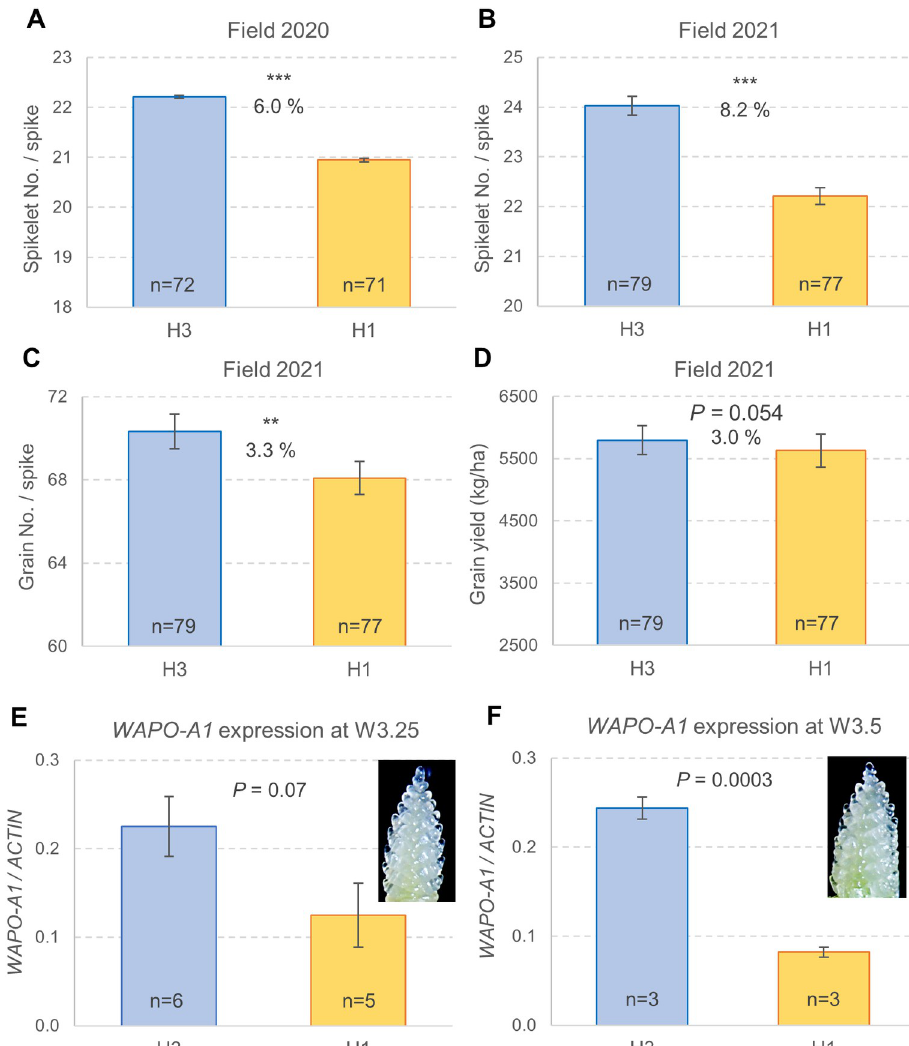
Fig 7. Effect of WAPO-A1 haplotypes H1 and H3 on SNS and WAPO-A1 transcript levels. ( A ) 2020 RCBD-split plot field experiment. ( B-D ) 2021 RCBD split-plot field experiment. ( B ) Spikelet number per spike. ( C ) Grain number per spike. ( D ) Grain yield (kg/ha) ( E-F ) Independent qRT-PCR experiments comparing H1 and H3 transcript levels of WAPO-A1 relative to ACTIN using the 2 Δ Ct method. ( E-F ) Pools of 3–8 developing spikes from the main tiller. ( E ) Collected when lemma primordia were present (W3.25). ( F ) Collected when floret primordia were present (W3.5). Bars represent averages and error bars are s.e.m. Numbers inside the bars indicate the number of replications. ns = not significant, � = P < 0.05, �� = P < 0.01 and ��� = P < 0.001. Data used for this figure are available in Data G in S1 Data, and the statistical analyses in S3